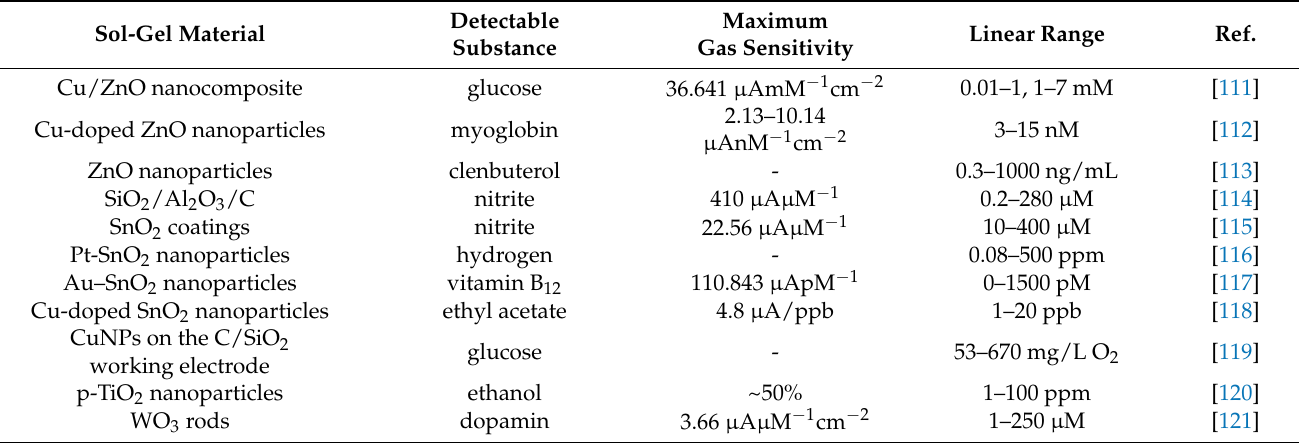
Table 5. Characteristics of some electrochemical sensors based on sol-gel